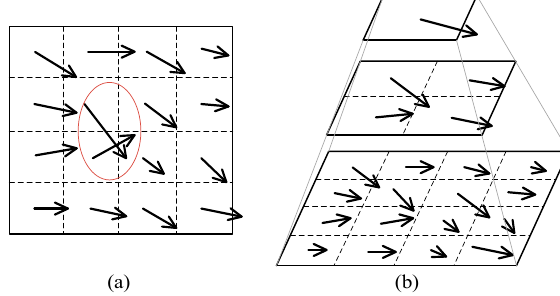
ff ect; ( b ) LOD-based visual e ff